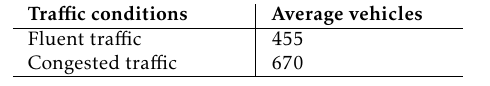
Table 4. Traffic scenarios in the 2.88 km 2 area of Bologna.